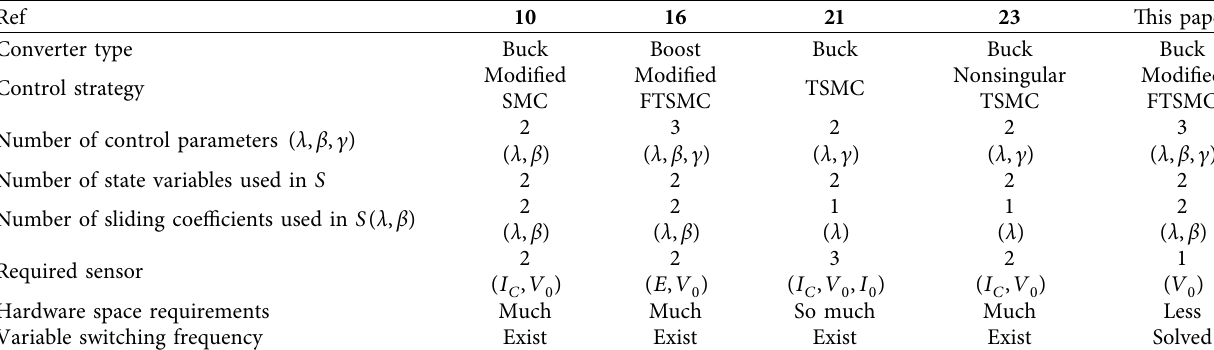
Figure 15: Proposed controllers against (a) uncertainty in inductor; (b) uncertainty in capacitor. Table 2: Comparison of four studies with proposed control method from various